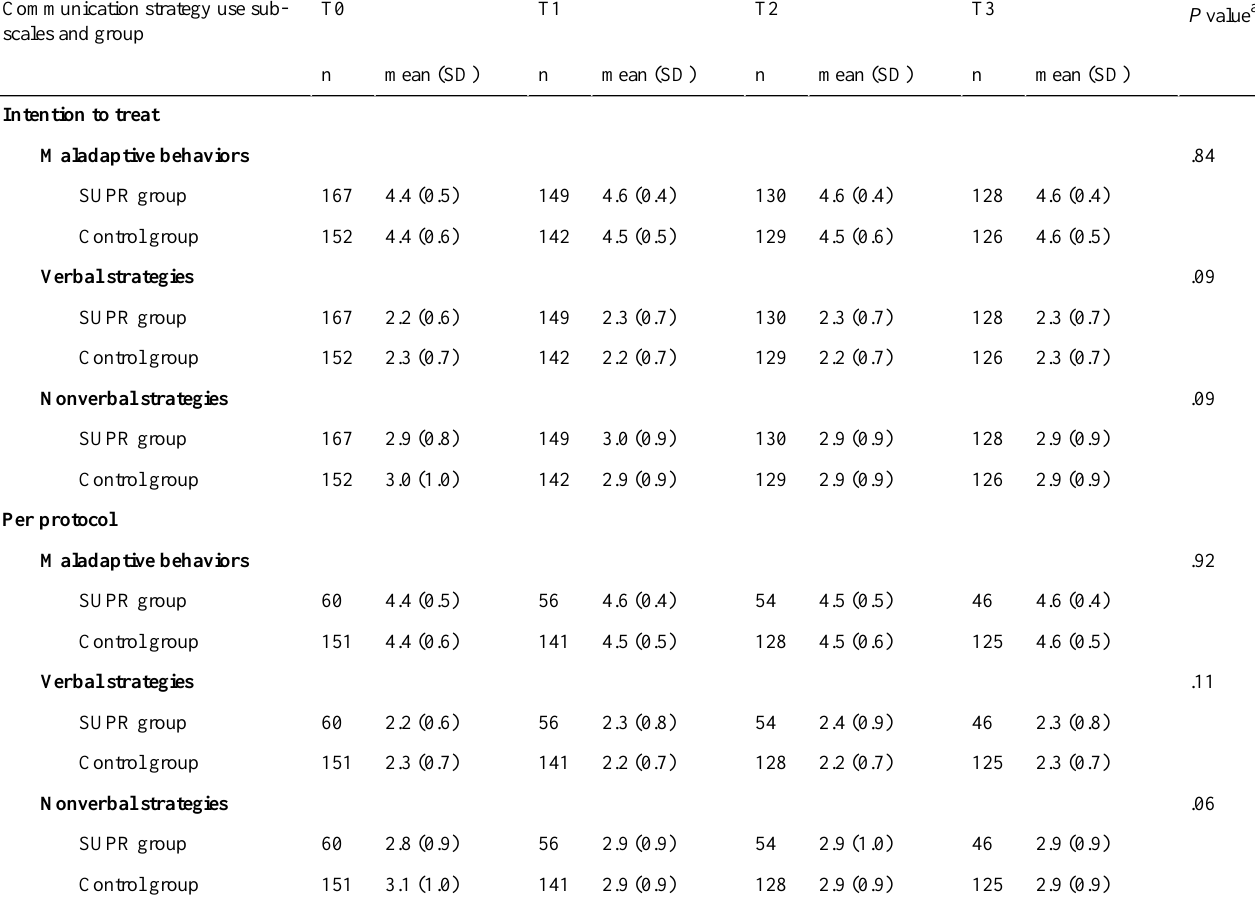
Table 3. Descriptive statistics and results of the linear mixed models on communication strategy use (Communication Profile for the Hearing Impaired; primary